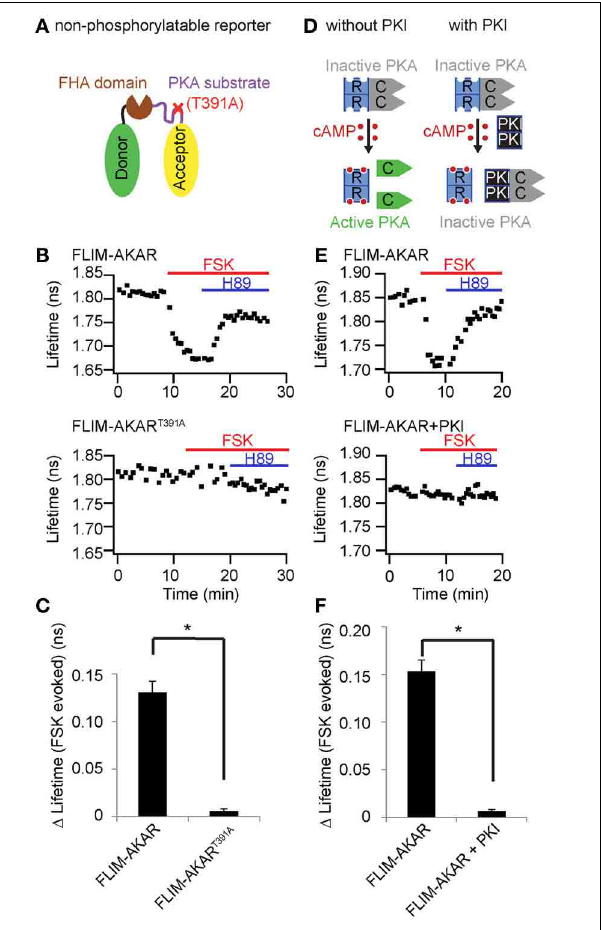
FIGURE 5 | FLIM-AKAR is specific for PKA following adenylate cyclase activation by forskolin. All experiments were performed in HEK cells. Red line indicates bath application of 50 μ M forsklin (FSK) and blue line indicates bath application of 10 μ M H89. (A) Schematic illustrating introduction of the point mutation T391A that renders the PKA phosophorylation site of FLIM-AKAR non-functional. (B) Example plots showing FLIM-AKAR lifetime response to adenylate cyclase activation by forskolin (red) and subsequent PKA inhibition by H89 (blue) (top), and the lack of a response from the non-phosphorylatable point mutant FLIM-AKAR T391A (bottom). (C) Summary bar graph showing (cid:2) lifetime from baseline to forskolin treatment for FLIM-AKAR ( n = 9 cells) and the non-phosphorylatable mutant of FLIM-AKAR ( n = 11 cells). ∗ p < 10 − 5 . (D) Schematic illustrating how PKI inhibits PKA activity. Without PKI, binding of cAMP to the regulatory subunits of PKA (R) frees the catalytic subunits (C), resulting in activation of PKA. With PKI, even though cAMP binding to the regulatory subunits dissociates them from the catalytic subunits, PKI can bind to the catalytic subunits of PKA and inhibit their activity. (E) Example plot showing FLIM-AKAR response to adenylate cyclase activation and subsequent PKA inhibition (top), and the lack of a lifetime response by FLIM-AKAR when it was co-transfected with PKI α (bottom). (F) Summary bar graph showing (cid:2) lifetimes from baseline to forskolin treatment for FLIM-AKAR, in the absence ( n = 18 cells) and presence ( n = 10 cells) of PKI. ∗ p < 10 − 9